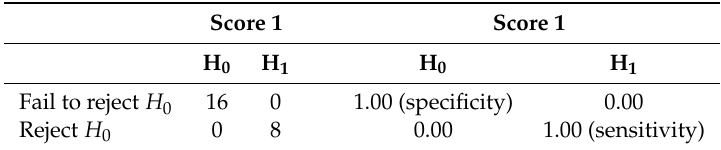
Table 14. Categorization of the samples with respect to the presence or absence of a fault and the result of the test for the first score when the size of the samples to diagnose is ν = 50, L b = 25, and the sensors used are numbers 1,2,4,5,6 and